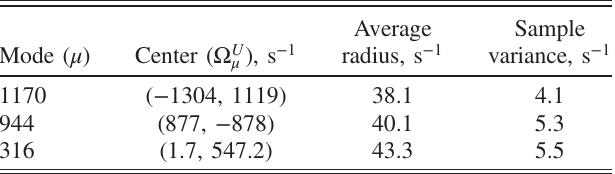
TABLE III. Gerschgorin column disks for practical case